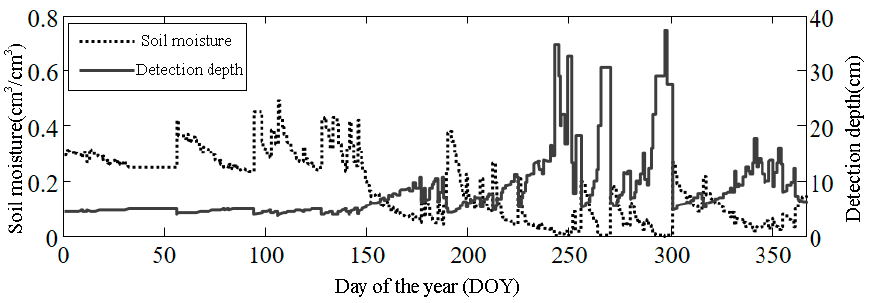
Figure 10. Daily soil moisture throughout the year 2012 and the detection depth of the GNSS signal at Station P041.